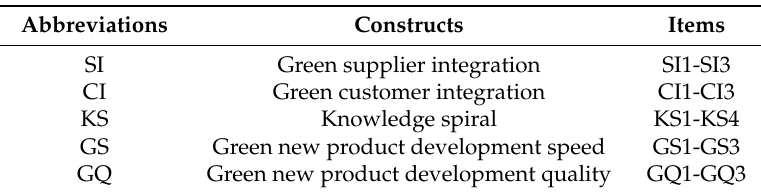
Figure 3. The structural equation model. (Note: *** p -value is less than 0.001; ** p -value is less than 0.01; * p -value is less than 0.05.). Table 5. Glossary of abbreviations.